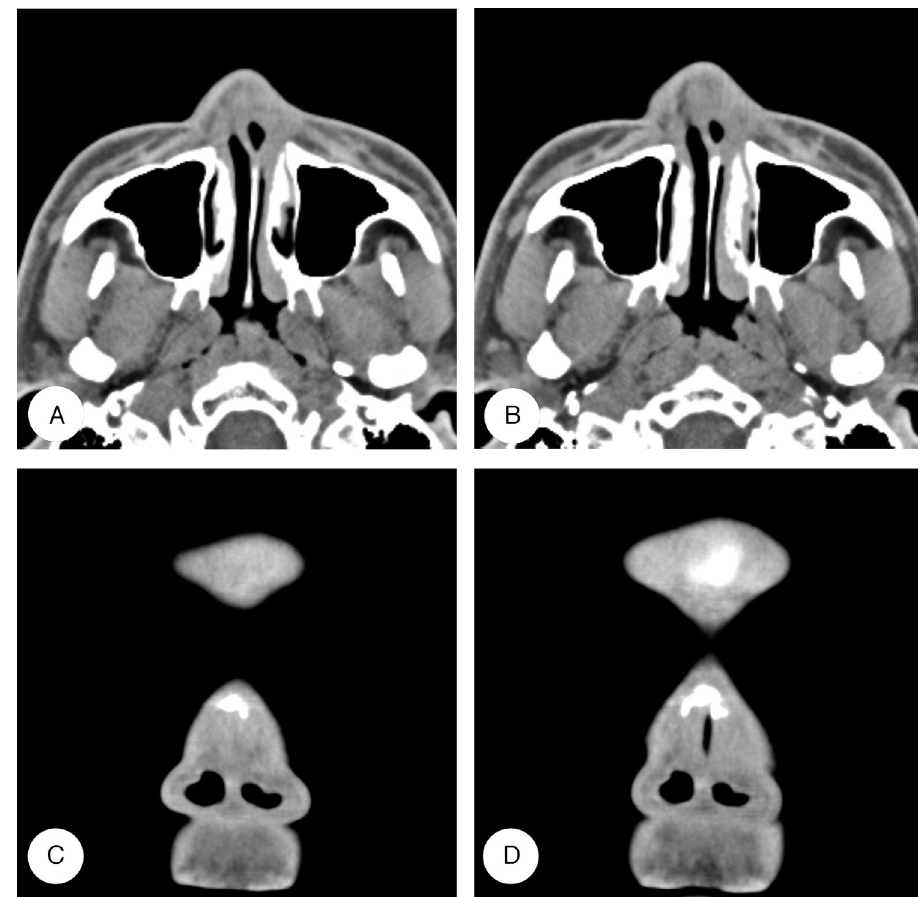
Figure 2 Preoperative facial computed tomograms. Axial (A, B) and coronal (C, D) images show soft tissue synechiae within the both nasal vestibule causing a vestibular stenosis. Nasal septum deviation to the left side is noted.